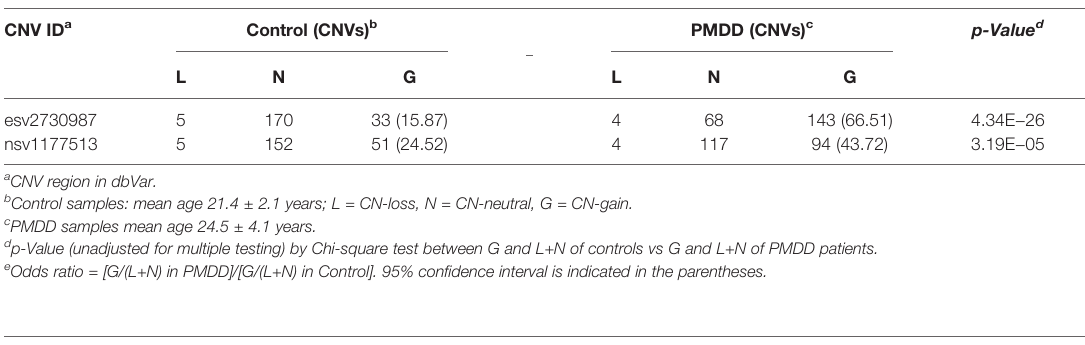
TABLE 3 | Copy number variations in PMDD female patients of Chinese